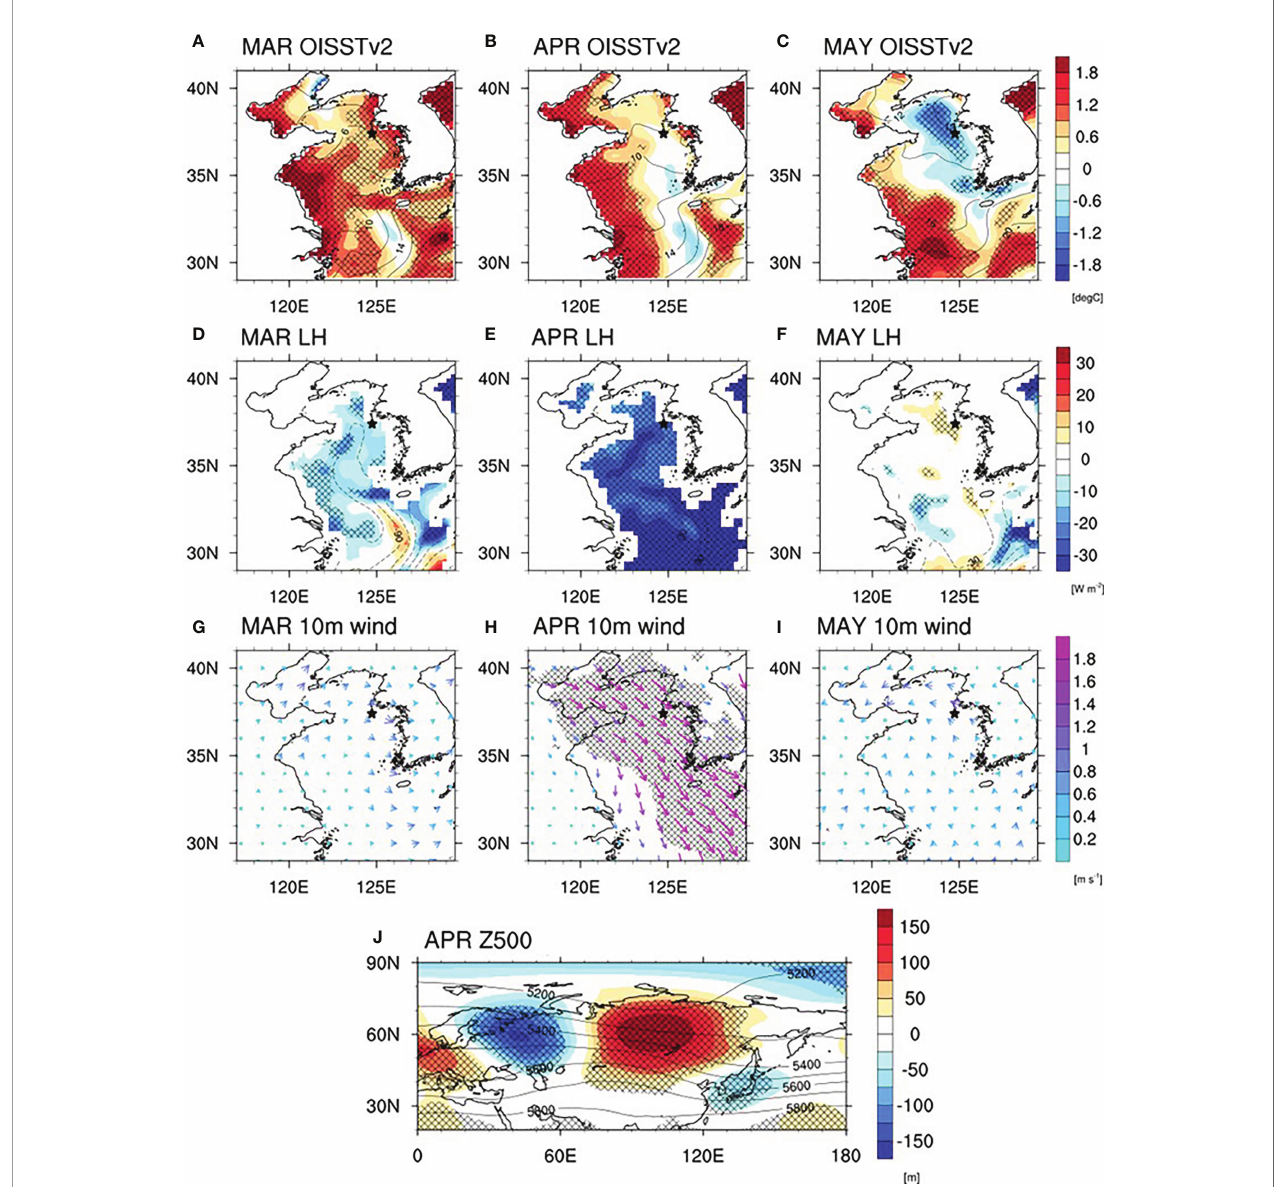
FIGURE 5 | Spatial evolution of 2020 anomalies in (A – C) SST (°C), (D – F) latent heat fl ux (LH, W m -2 ), (G – I) 10m wind vector (m s -1 ), and (J) 500-hPa geopotential height (Z500, m) during the boreal spring. The contours in (A – F, J) denote the climatological fi elds from 1982 to 2019. The contour intervals are 2°C in (A – C) , 30 W m -2 (D – F) , and 100 m (J) . The hatched areas in (A – J) represent the statistically signi fi cant regions at a 90% con fi dence level. The negative latent heat fl ux means heat loss from the ocean to the atmosphere (positive